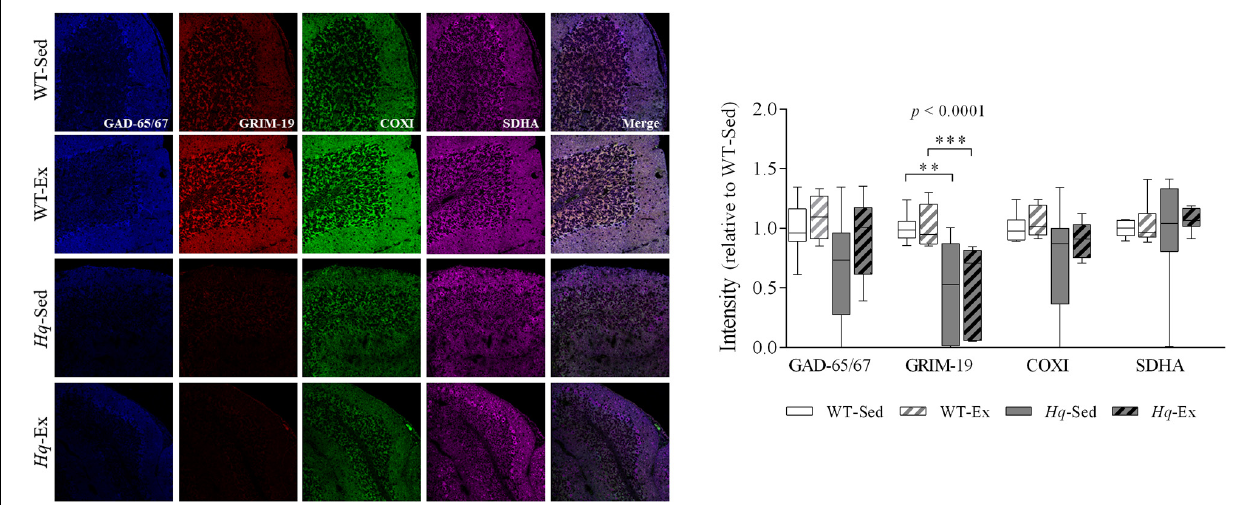
FIGURE 2 | Immunohistochemistry analysis of respiratory complexes and Purkinje neuron markers. Immunodetection of markers of Purkinje cells, GAD-65/67 (blue); respiratory chain complex I, GRIM-19 (red); complex IV, COXI (green); complex II, SDHA (violet); and merged images in slices of cerebellum of wild-type sedentary (WT-Sed, n = 10) and exercise-trained (WT-Ex, n = 9) mice, and Hq sedentary ( Hq- Sed, n = 10), and exercise-trained ( Hq -Ex, n = 8) mice. Quantitative analysis of the signal intensities: data (median, interquartile range, and min and max values) are expressed relative to the intensity of the WT-Sed group. Significant p- values for group effect (Kruskal-Wallis test) are shown above the corresponding boxes. Symbols for significant differences in post hoc pairwise comparisons: ∗∗ p < 0.01; ∗∗∗ p < 0.001 for Hq -Sed vs WT-Sed, and Hq -Ex vs. WT-Ex. Abbreviations: COXI, cytochrome c oxidase subunit I; GAD-65/67, glutamate descarboxilase 65/67; GRIM-19, gene associated with retinoic and interferon-induced mortality 19 protein; SDHA, succinate dehydrogenase complex iron sulfur subunit A. Analyses were performed in 1,000 cells ( i.e. , 187 cells for 7 WT-Sed animals; 168 cells for 5 WT-Ex animals; 293 cells for 6 Hq -Sed 6 animals, and 352 cells for 5 Hq -Ex animals).